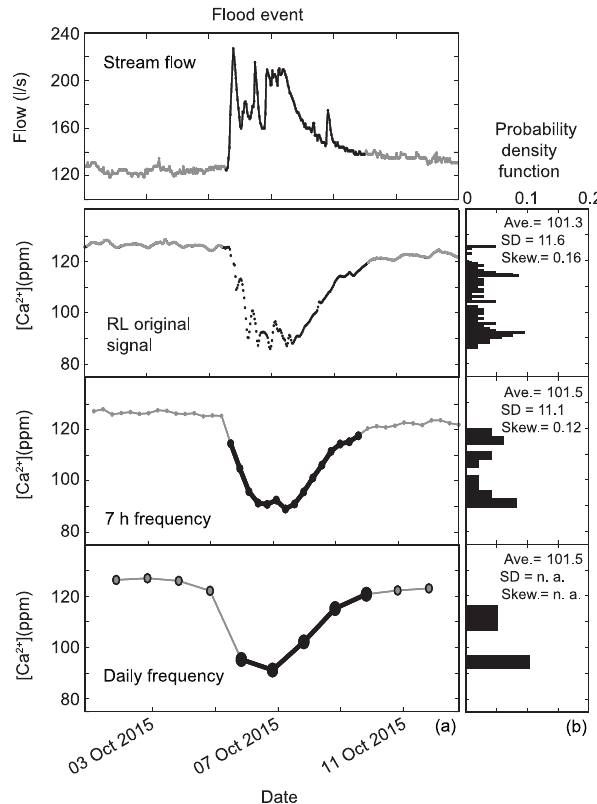
Figure 5. (a) Calcium concentration and stream flow in the Orgeval River during a rain event (from 1 to 25 October 2015), sampled ev- ery 40min (RL original signal at 40min frequency) and artificially subsampled every 7h and every day at 10:00. Black dots represent data during the rain event strictly (from 5 to 10 October 2015 at 10:00), over which probability density functions (PDFs) of concen- tration are calculated and represented as histograms (b) . For each PDF, the following statistical parameters are calculated: average (Ave.), standard deviation (SD), and skewness (Skew.). Grey dots represent concentration values outside of the rain event and are not considered in the corresponding PDF. The two statistical parameters standard deviation (SD) and skewness (Skew.) are not calculated for the daily subsampling because of the too small number of